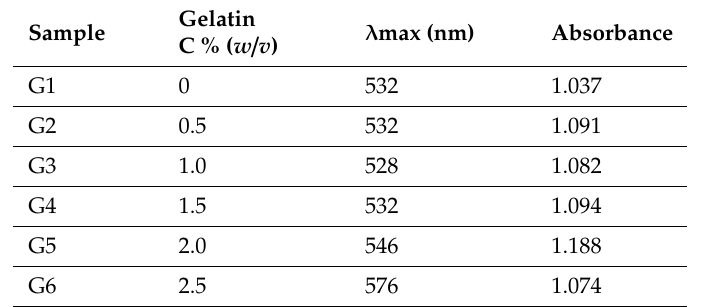
Figure 1. UV-Vis adsorption spectra of branched gold nanoparticles (AuNPs) synthesized by gelatin Figure 2. Representative TEM images of synthesized AuNPs with ( a ) low gelatin concentration (1.0% with different concentrations of ( a ) 0, ( b ) 0.5, ( c ) 1.0, ( d ) 1.5, ( e ) 2.0, ( f ) 2.5% (w/v). w/v) (scale 50 nm), ( b ) high gelatin concentration (2.5% w/v) (scale 100 nm) and ( c ) histogram of particle size distribution of synthesized AuNPs with low gelatin concentration (1.0% w/v).